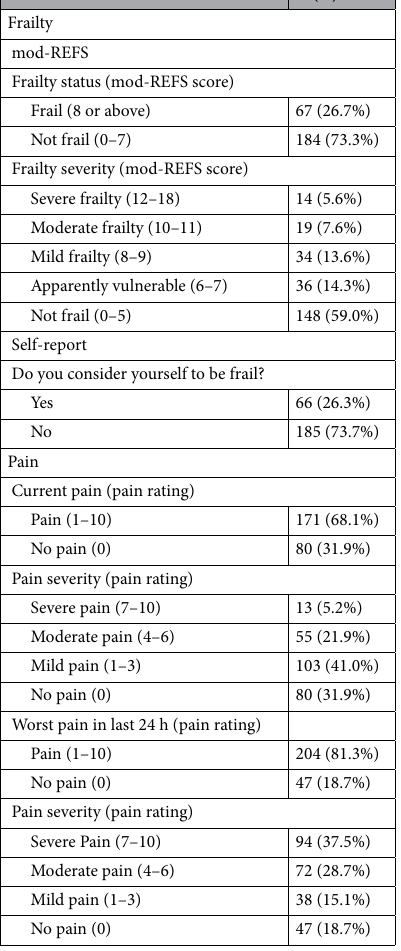
Table 1. Prevalence of frailty and pain. mod-REFS modified Reported Edmonton Frail